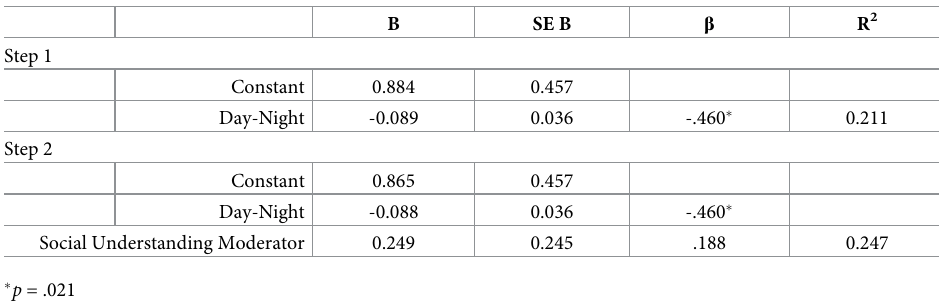
Table 1. Regression model inhibitory control and selective